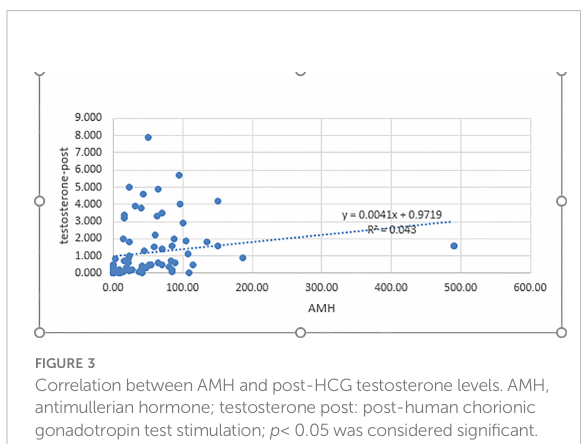
FIGURE 3 Correlation between AMH and post-HCGtestosterone levels. AMH, antimullerian hormone; testosterone post: post-human chorionic gonadotropin test stimulation; p< 0.05 was considered signi fi